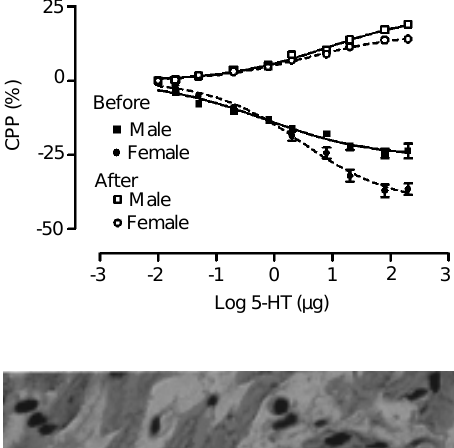
Figure 5. Histological sections perpendicular to the long axis of the heart. The tissues were stained with hematoxylin/eosin and serial blocks were cut at ap- proximately 3-mm intervals. Ar- row heads point to a myocardial vessel with the presence of typi- cal endothelial cells (top picture) and a denuded vessel following treatment with deoxycholate (bottom